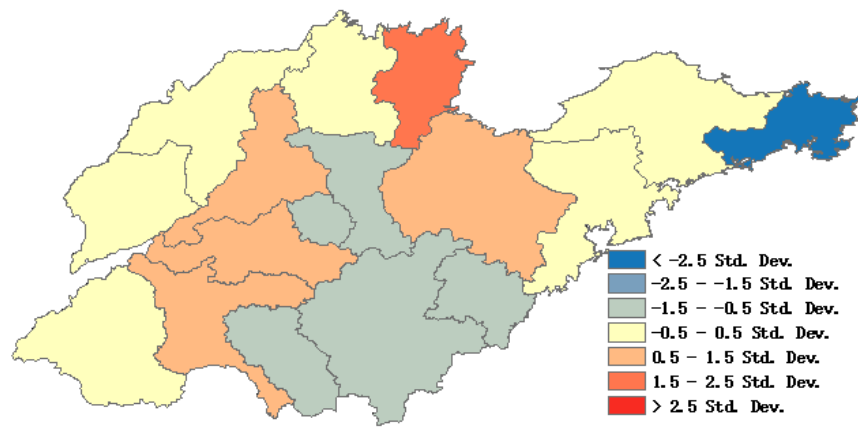
Figure 11. Geographically Weighted Regression (GWR) result graph.